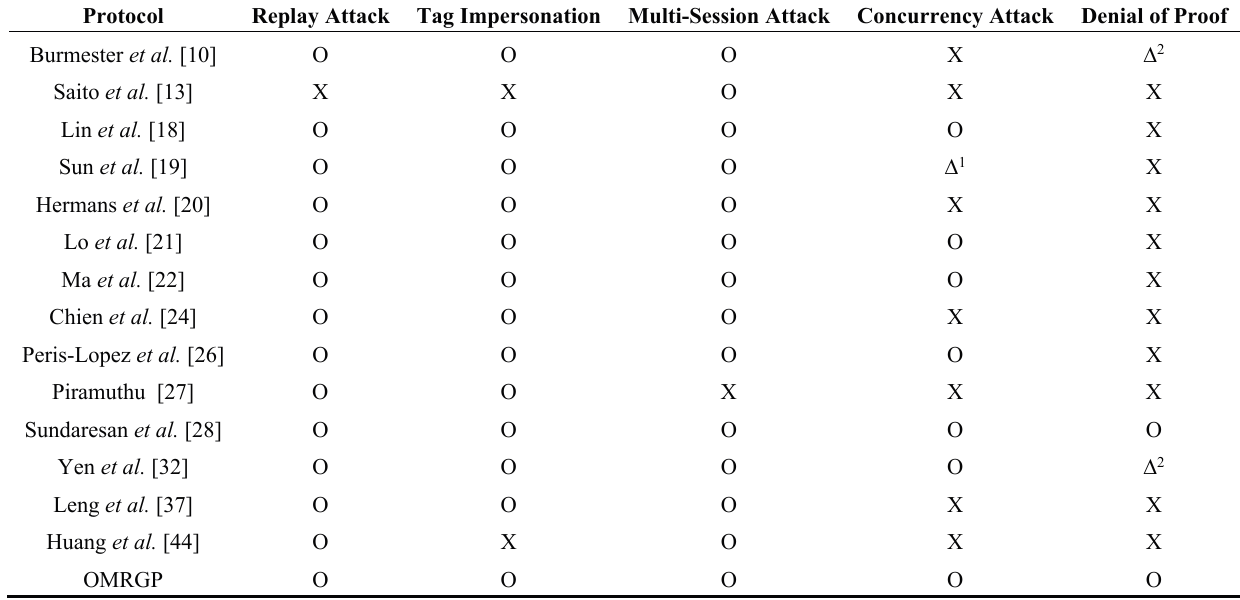
Table 2. Comparison table indicating the security of grouping